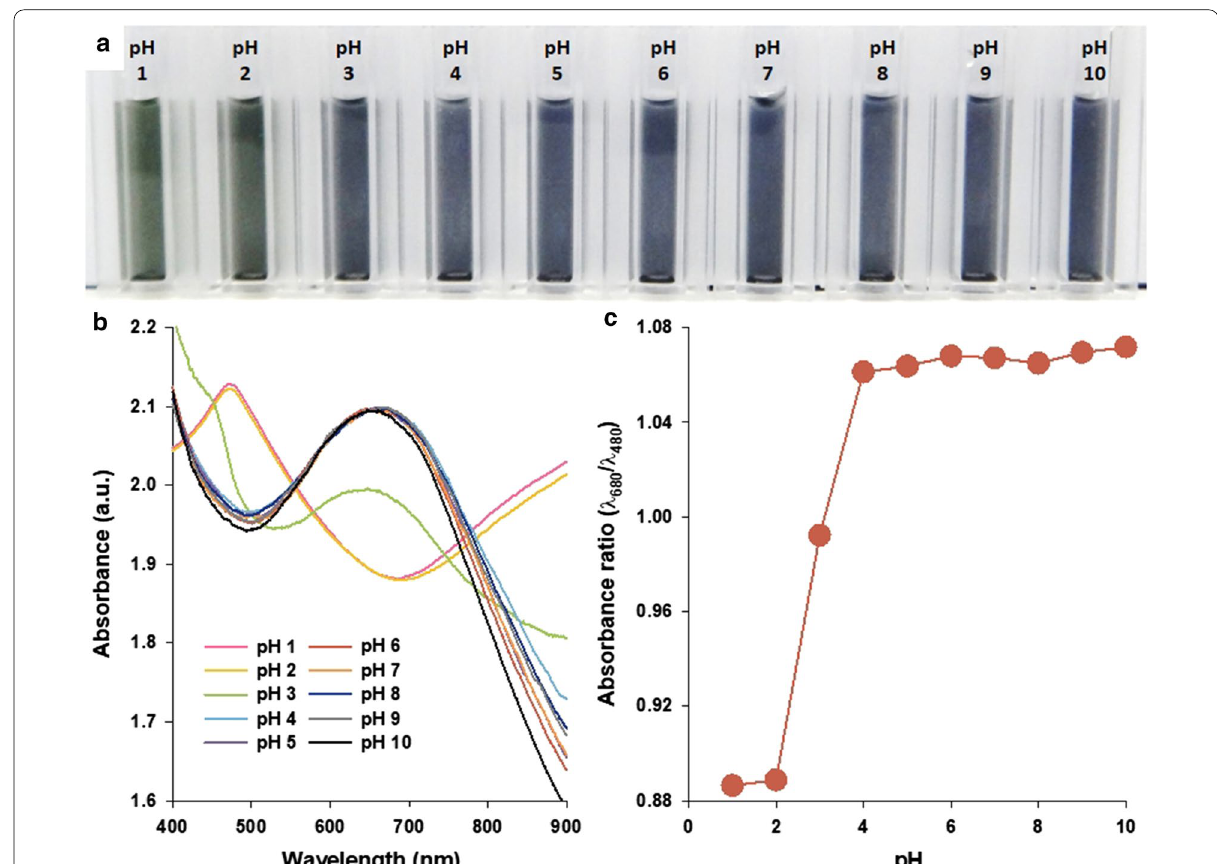
Fig. 4 a A photograph, b absorbance spectra, and c absorbance ratio for representative wavelengths for EB (at 680 nm) and ES (at 480 nm) states of PANS solutions in indicated pH